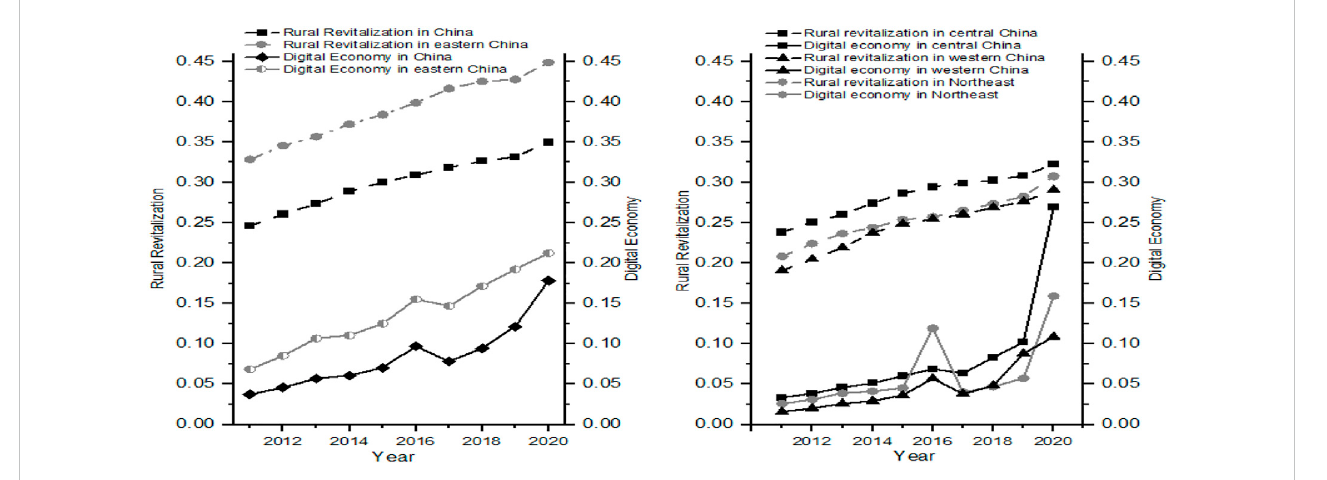
FIGURE 1 Trends of the digital economy and rural